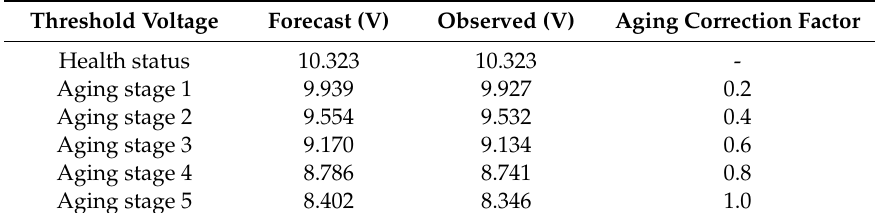
Table 5. The threshold voltage of IGBT aging stages.